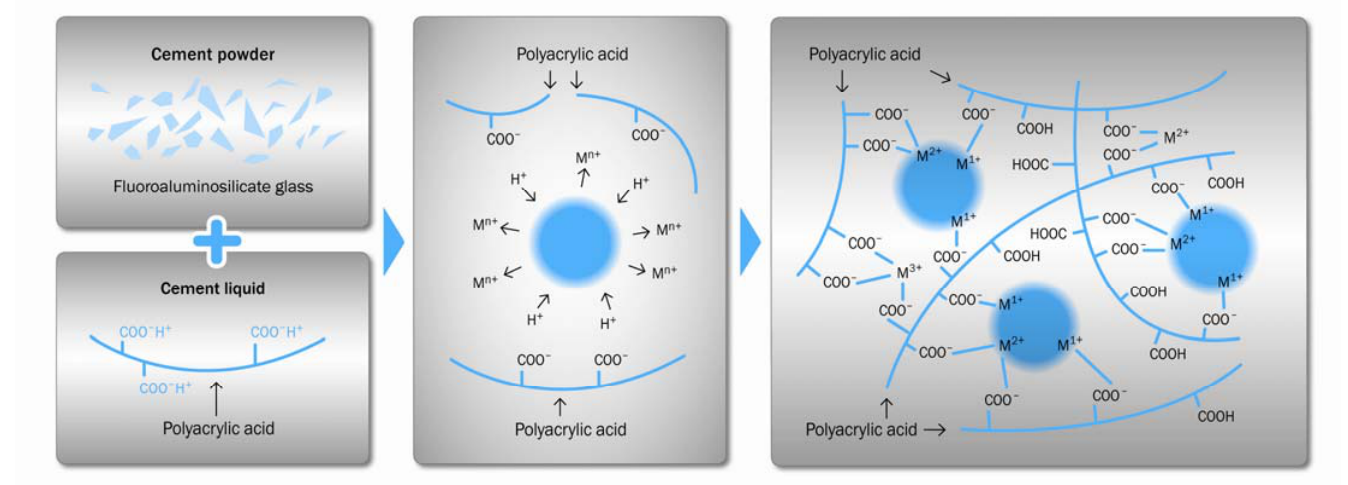
Figure 1. Setting reaction of a conventional glass-ionomer